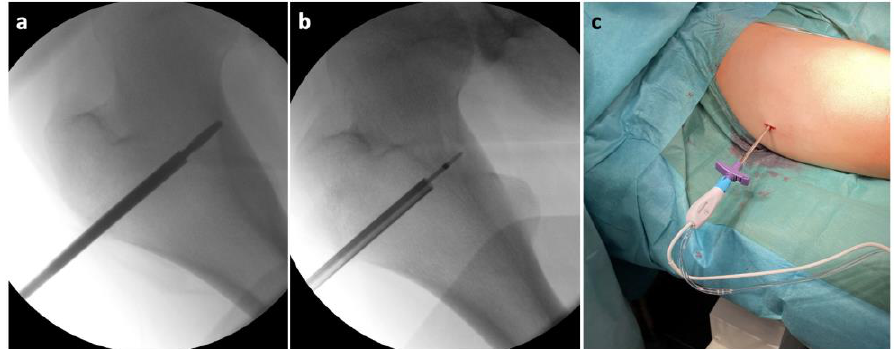
Figure 5. A bioptic sample of the osteoma.